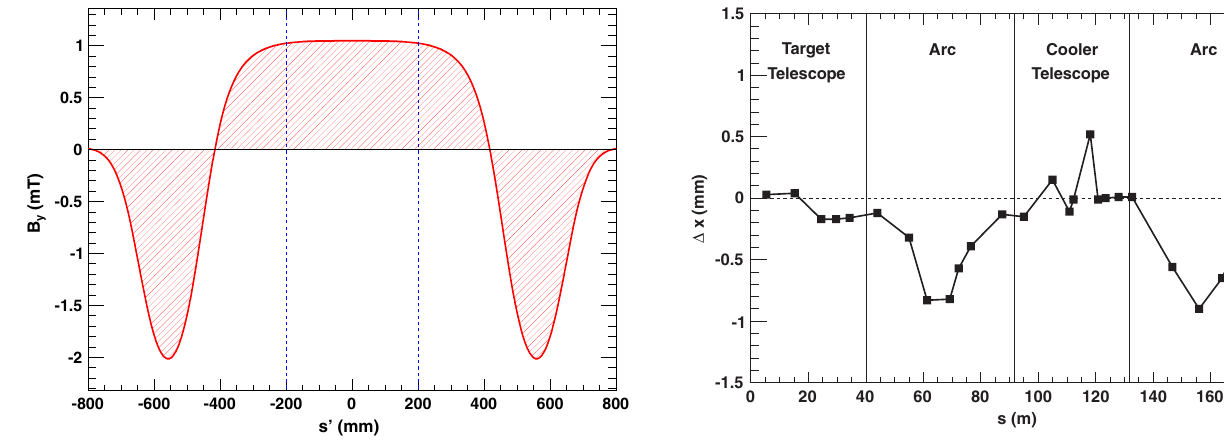
FIG. 7. Calculated vertical magnetic flux density B s 0 -direction for the coil configuration of Fig. 6. In the target cell region ( s 0 ¼ − 200 mm to þ 200 mm), indicated by the vertical dashed bars, the magnetic field is about 1 mT.